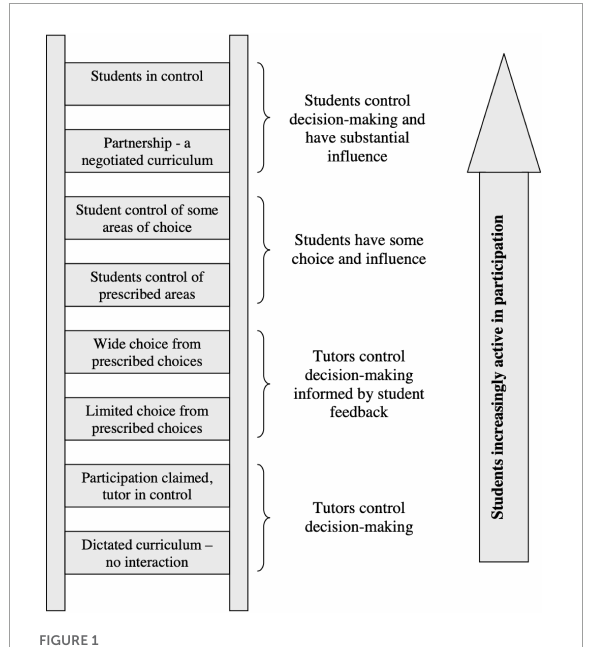
FIGURE1 Ladder of student participation in curriculum design (Bovill and Bulley, 2011, p.5).